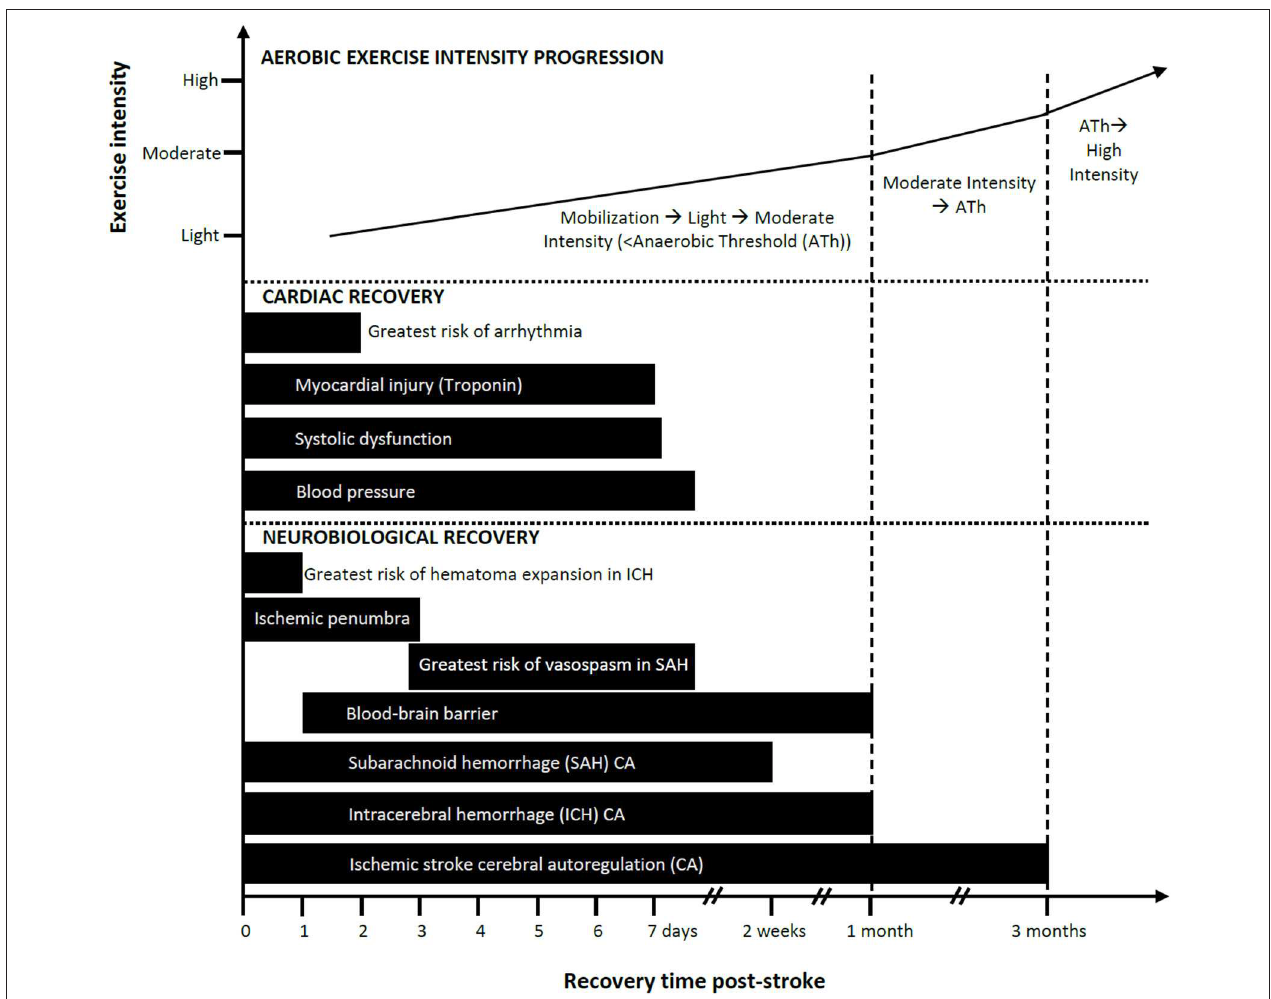
FIGURE 1 | Progression of mobilization and aerobic exercise intensity in relation to estimated neurobiological and cardiac recovery post-stroke: a conceptual model. Aerobic exercise can ideally increase in intensity as a function of elapsed time post-stroke and should be guided based on cardiopulmonary fitness measures such as the anaerobic threshold (Ath). Safe and recommended periods to introduce exercise/mobilization post-stroke are shown here as varying by cardiac and neurobiological recoveries. Impaired cerebral autoregulation after ischemic stroke is listed here as the longest time to recovery. Recovery is based on available